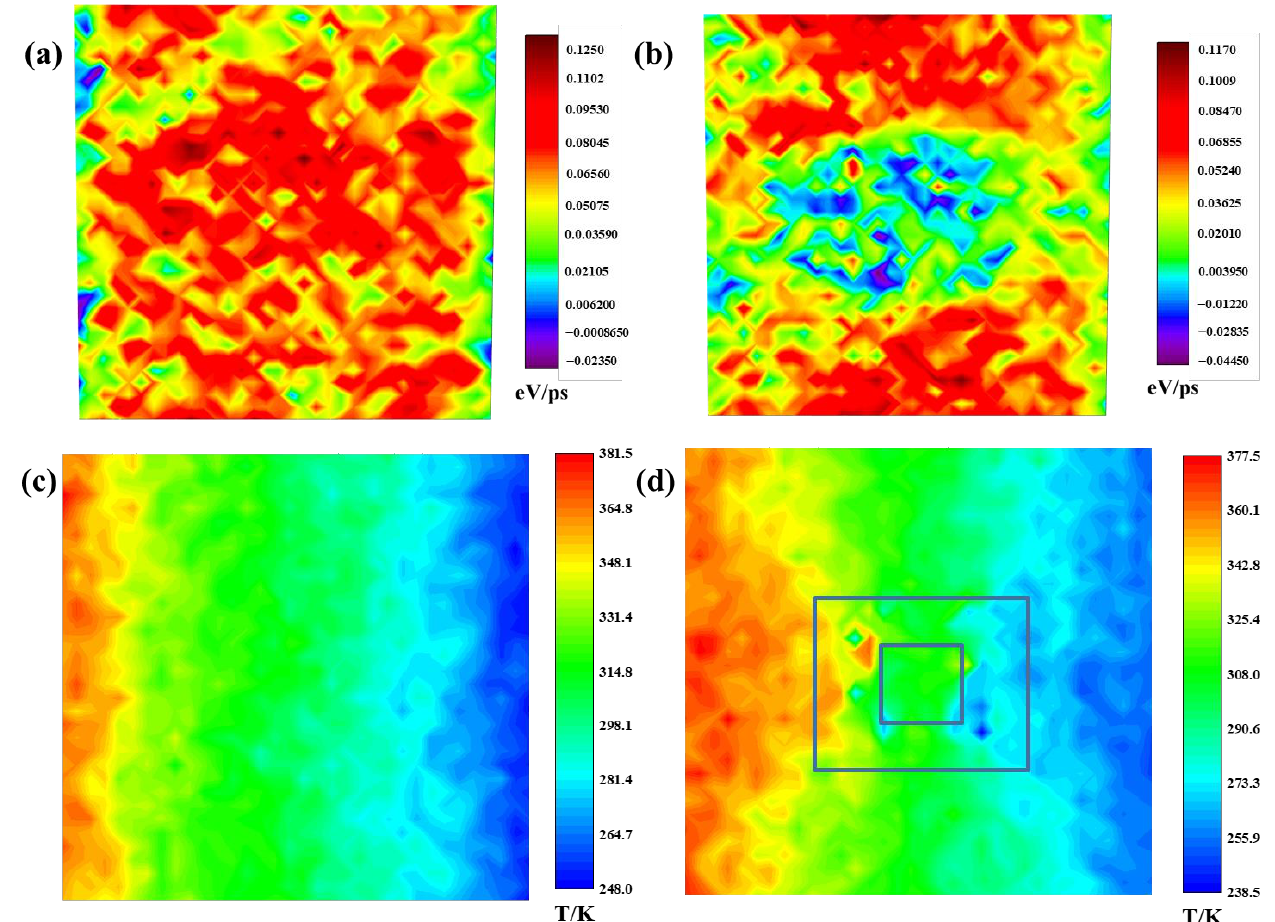
Figure 6. ( a , b ) The heat flux distribution at 600 ps, where ( a ) is the crystalline film, and ( b ) is the nanocloak; ( c , d ) the temperature distribution at 600 ps, where ( c ) is the crystalline film, and ( d ) is the nanocloak.